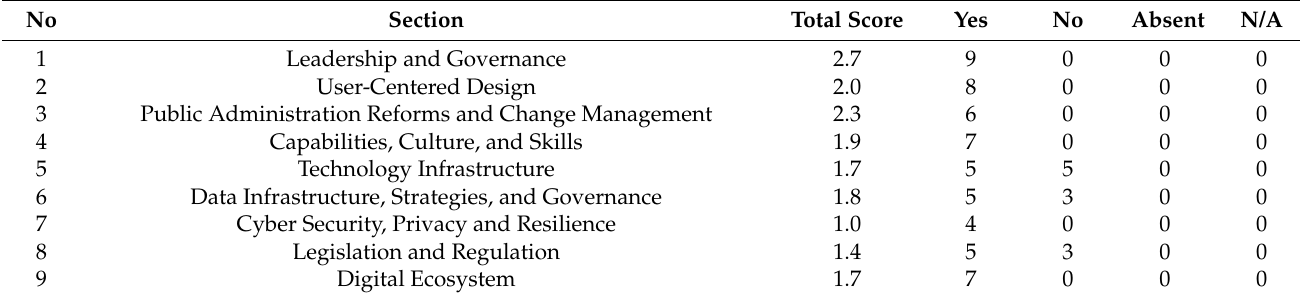
Table 3. The DGRA results for land services in the Ministry of Agrarian and Spatial Planning/National Land Agency